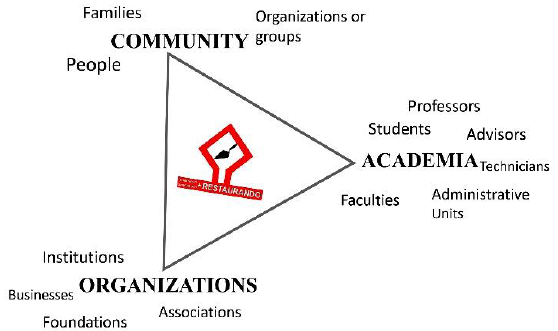
Figure 1. Main actors involved in maintenance campaigns. Source: Alicia Tenze, 2019 Two campaigns have been carried out in rural areas (Susudel houses in 2011 and Susudel cemetery in 2013) and one in the traditional neighborhood of San Roque, in the city of Cuenca in 2014. In these first three campaigns, the main objective was to realize maintenance actions of the physical parts of several heritage buildings (Cardoso, Achig-Balarezo & Barsallo,